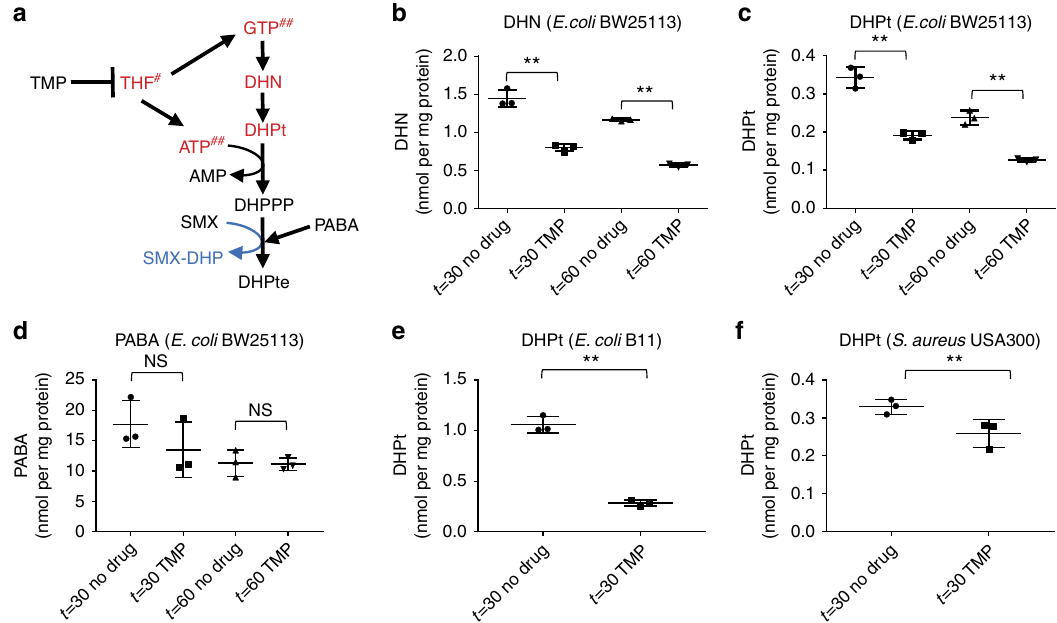
Fig. 3 TMP inhibits DHPPP biosynthesis pathway. The impact of TMP on intracellular levels of a 7,8-dihydroneopterin (DHN) and b , e , f 6-hydroxymethyl- 7,8-dihydropterin (DHPt), c PABA were determined by using LC-MS/MS. The results represent the mean and standard deviation of three biological replicates. ** p < 0.05. NS indicates no signi fi cant difference ( p > 0.05). p -values of pairwise comparisons were calculated by using the Student ’ s t -test. d Effects of TMP on DHPPP biosynthesis pathway. Red characters are metabolites that decrease intracellular amount in response to TMP treatment (THF 23 , GTP 29 , and ATP 29 were reported